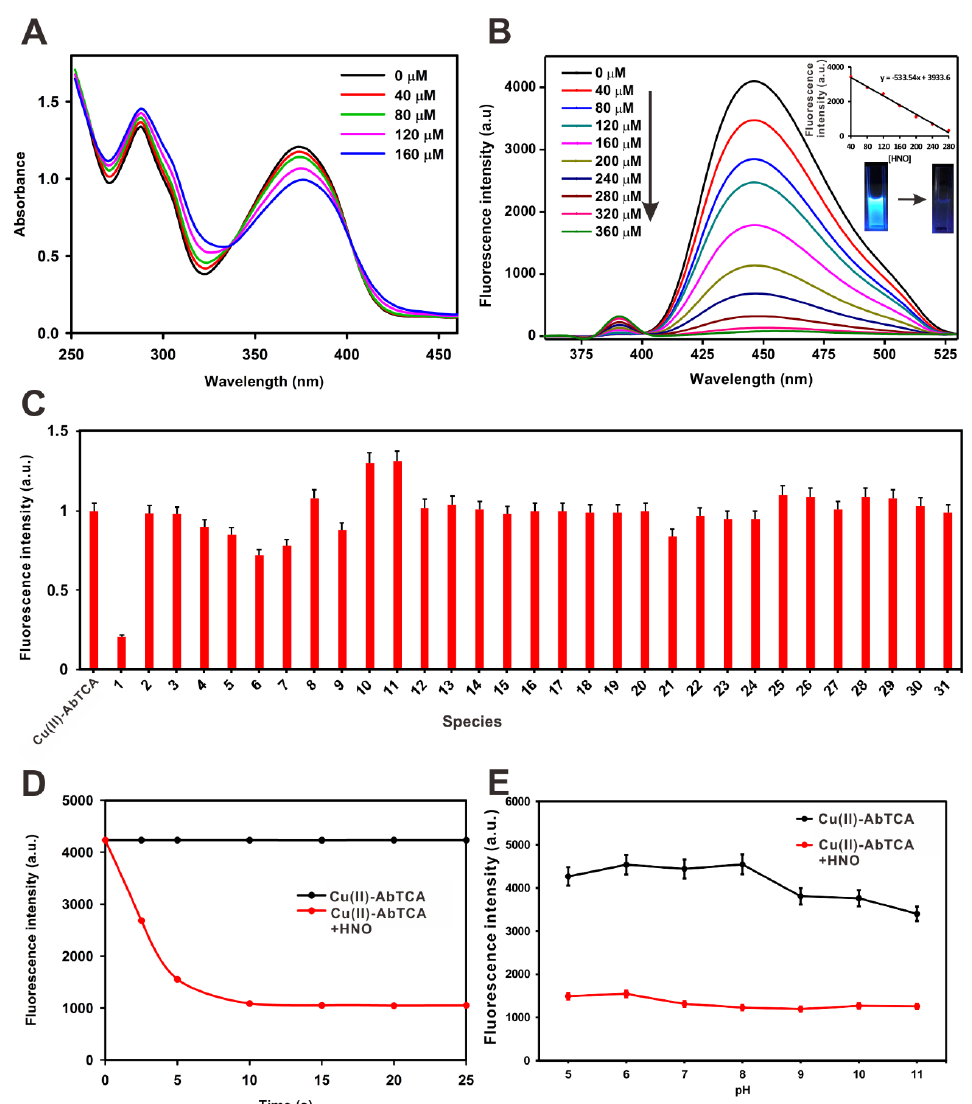
Figure 1. ( A ) UV-visible spectra of Cu(II)- AbTCA (40 μM) with the addition of increasing